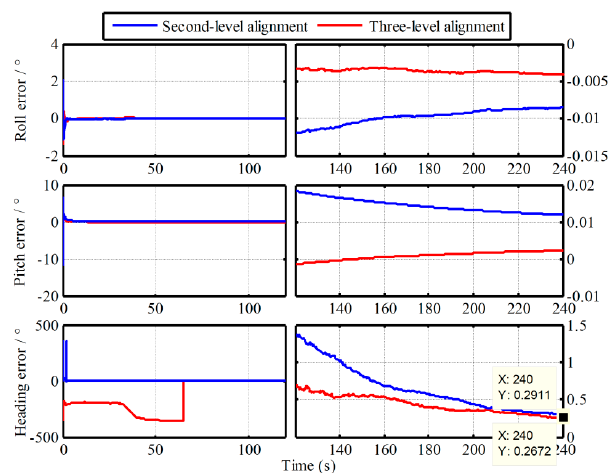
Figure 6. Errors curves of initial alignment with the proposed algorithm.